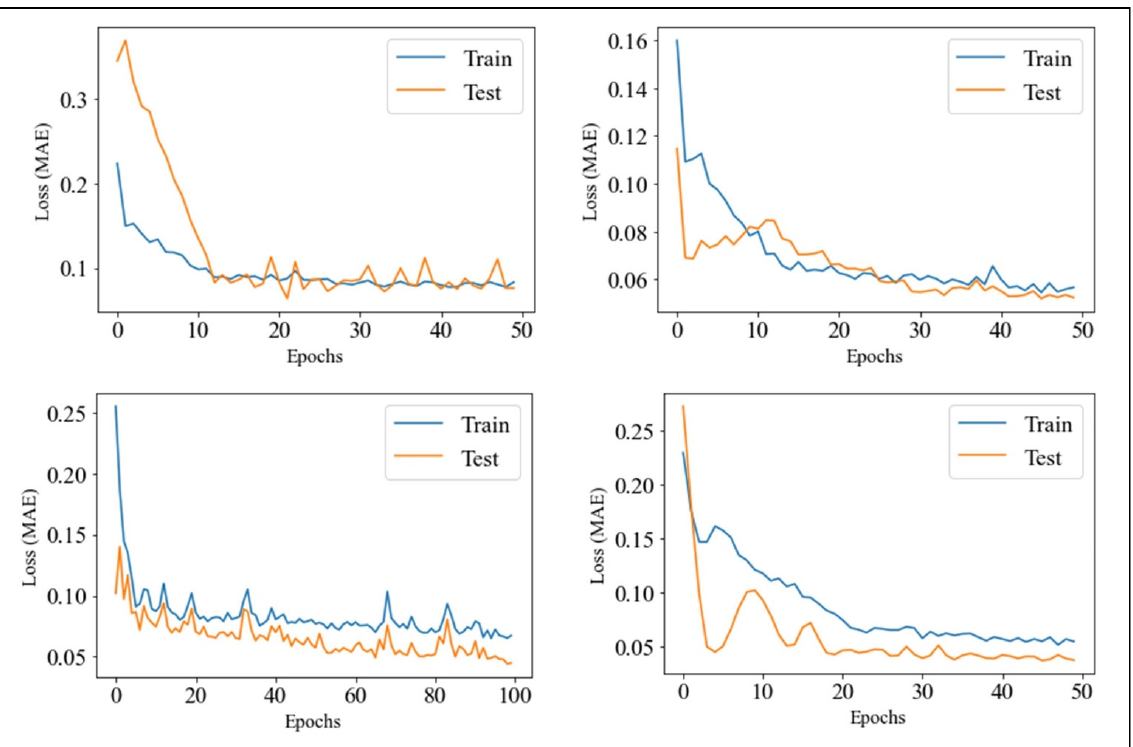
Figure 2. Train and test loss function ( Mean Absolute Error ) versus the number of epochs.